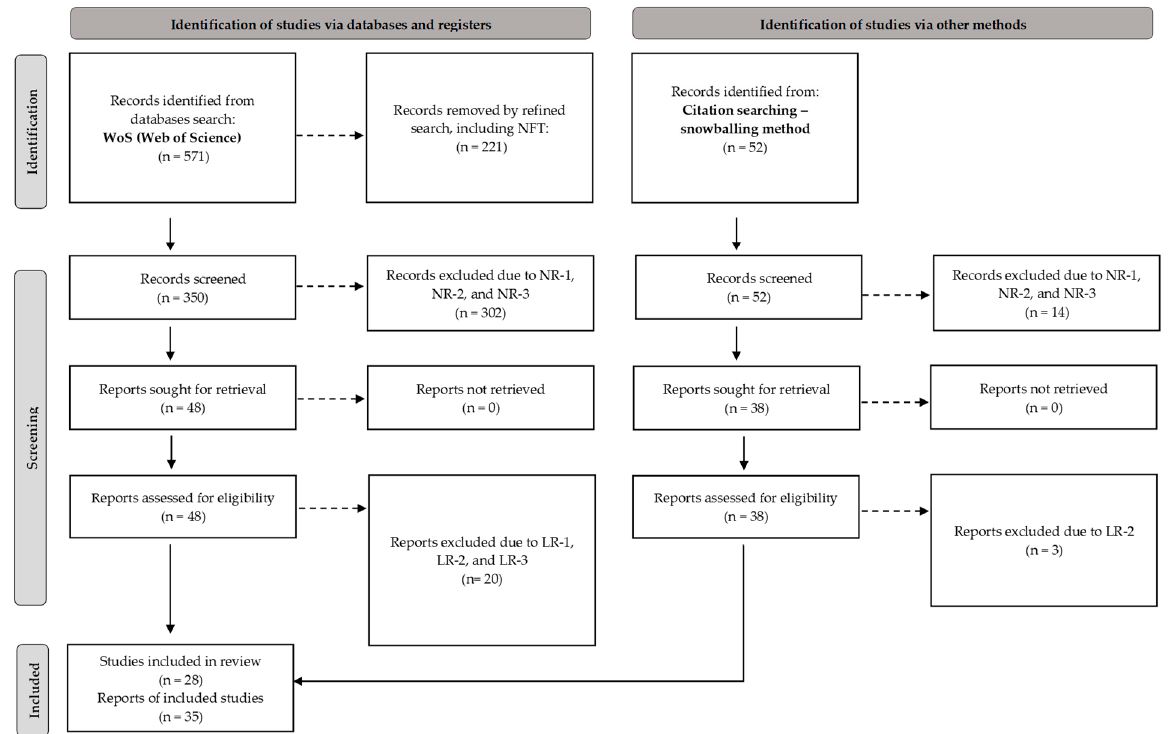
Figure 1. PRISMA diagram (adapted from Page et al. [67]).